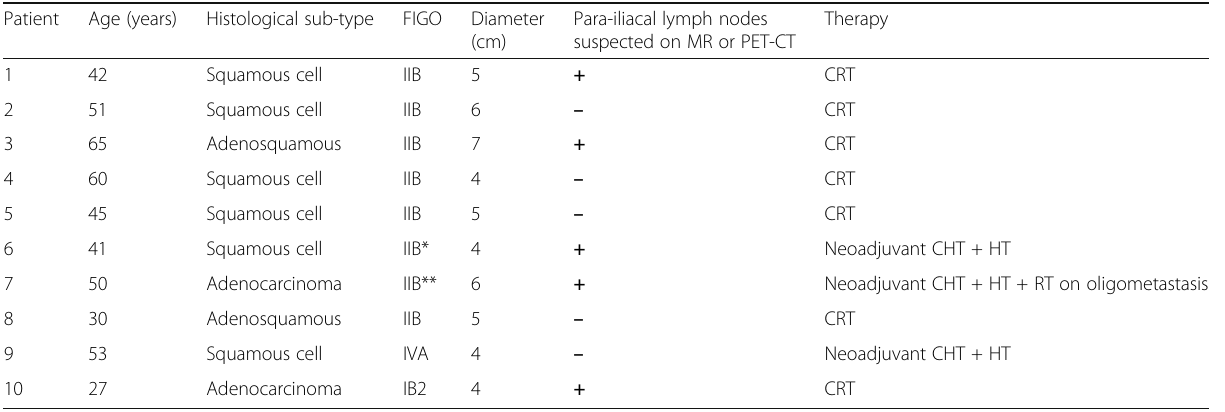
Table 1 Patient and tumor characteristics